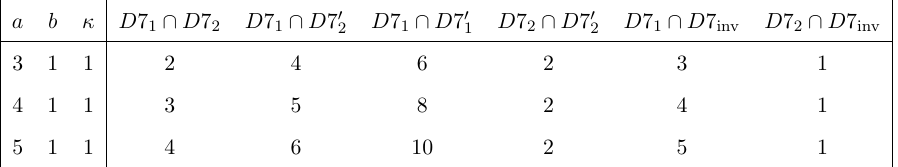
Table 12 . U(1) charges for the incomplete models with invariant